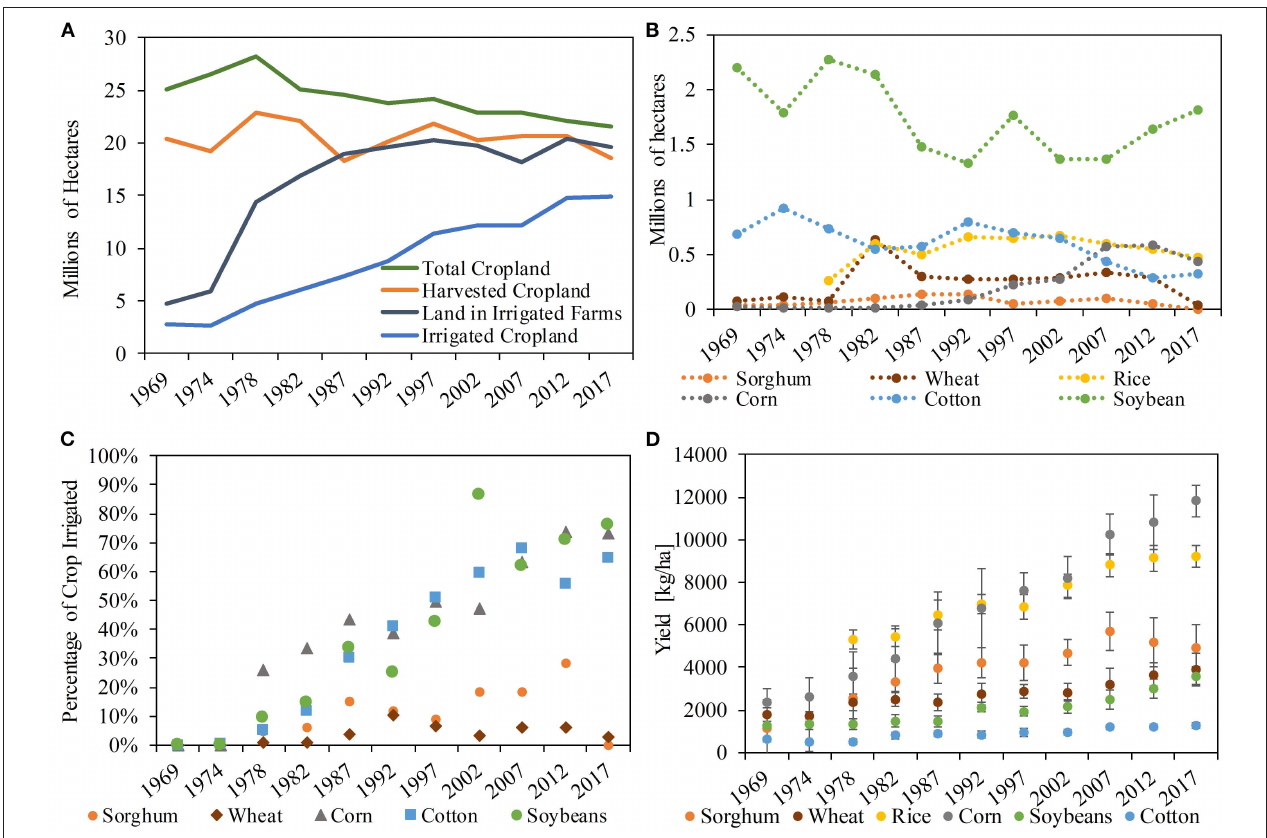
FIGURE 3 | (A) Temporal trends in total cropland, harvested cropland, land in irrigated farms, and irrigated cropland areas from 1969 to 2017 for all counties/parishes examined in study; (B) total crop area by major crop type in all counties/parishes analyzed from 1969 to 2017; (C) percentage of crop irrigated for all counties/parishes studied. Rice is not plotted as irrigation was 100% for all years that crop irrigation status is reported; (D) calculated crop yield using Census of Agriculture data for each major crop type from 1969 to 2017